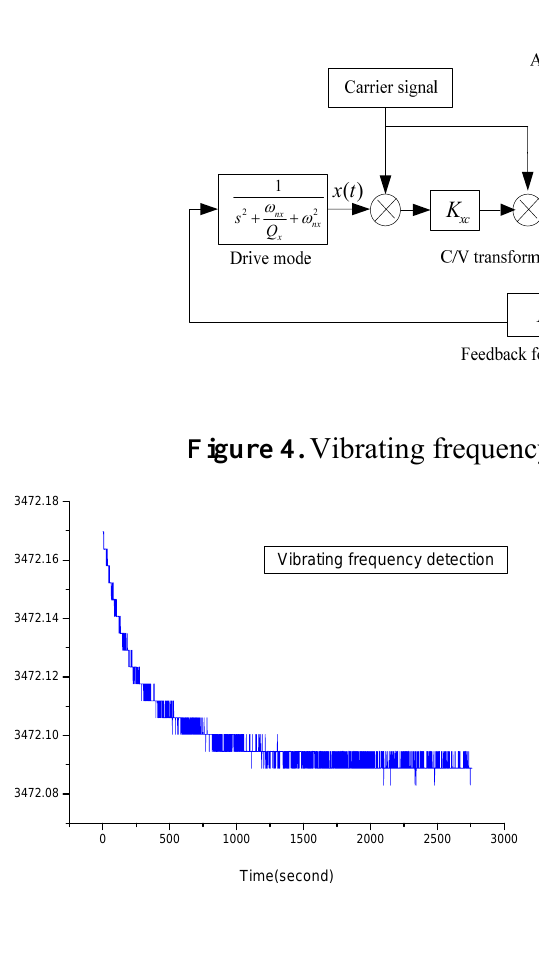
Figure 3. Drive mode circuitry method.